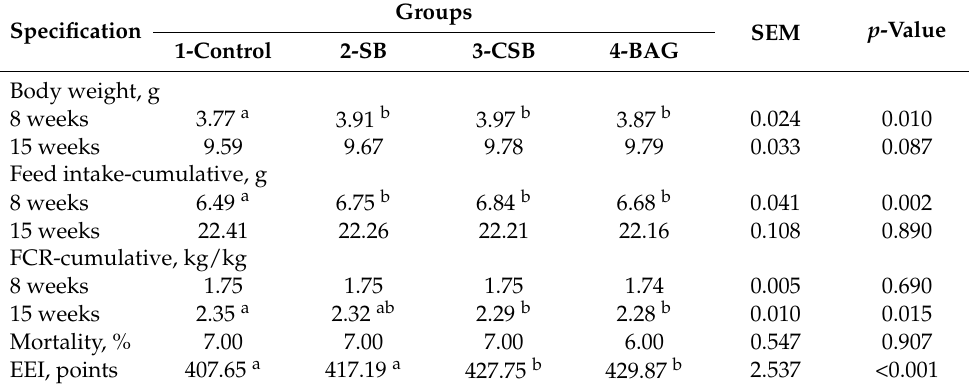
Table 2. Growth performance of turkeys.